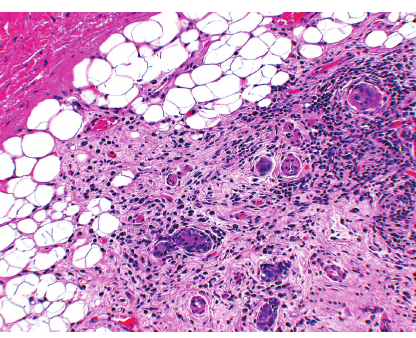
Figure 2: No-amifostine (HE, Original magnification × 28). The submandibular ductal remnants are within areas representing inter- stitial fibrosis as well as di ff use and focal lymphocytic infiltration.